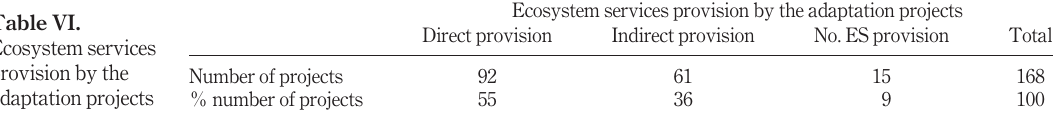
Table VI. Ecosystem services provision by the adaptation